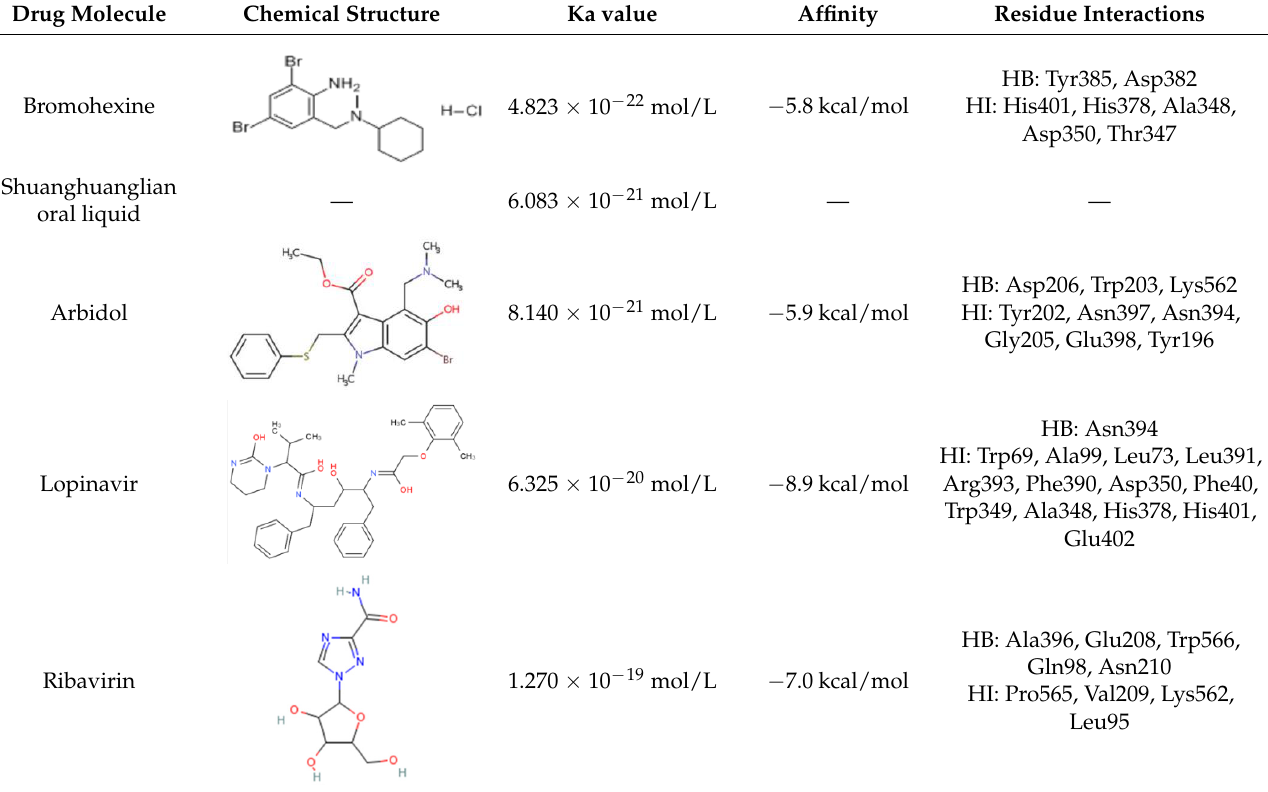
Table 2. Molecular docking simulation results and Ka values.